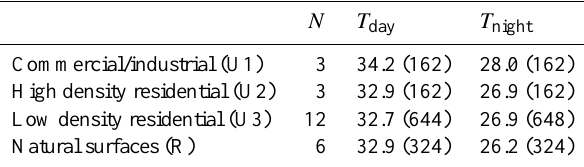
Table 4. Mean 2-m air temperatures for three urban classes and natural surfaces in specific time periods of a day. The temperatures were averaged for 9 hours during the daytime (09:00–17:00 LT) and nighttime (01:00–05:00 LT and 21:00–24:00 LT), respectively. N indicates the number of surface sites for each class, and the number of data averaged is denoted in